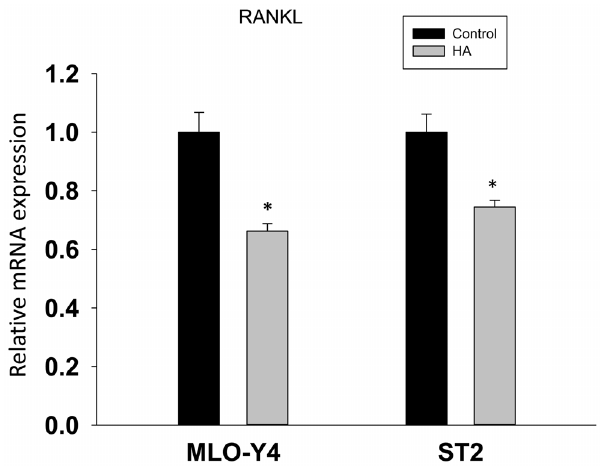
Figure 7. Effect of hippuric acid (HA) on RANKL gene expression in osteoblastic and osteocytic cells. MLO-Y4 and ST2 cells were treated with HA (1 m g/ml) for forty eight hours, RNA was isolated from cells for RANKL real-time PCR analysis. Data are means 6 SEM from triplicate treatment. *, p , 0.05 versus control by t test.